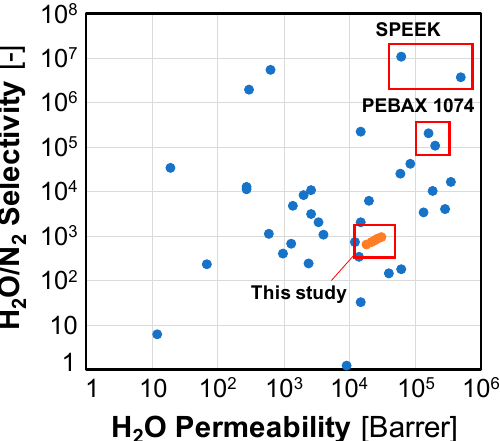
Figure 7. Performance data on H 2 O permeability/selectivity. In Figure 7, the data in the red boxes are a result of using the same membrane, but different indicator values are given depending on the analysis and calculation methods.